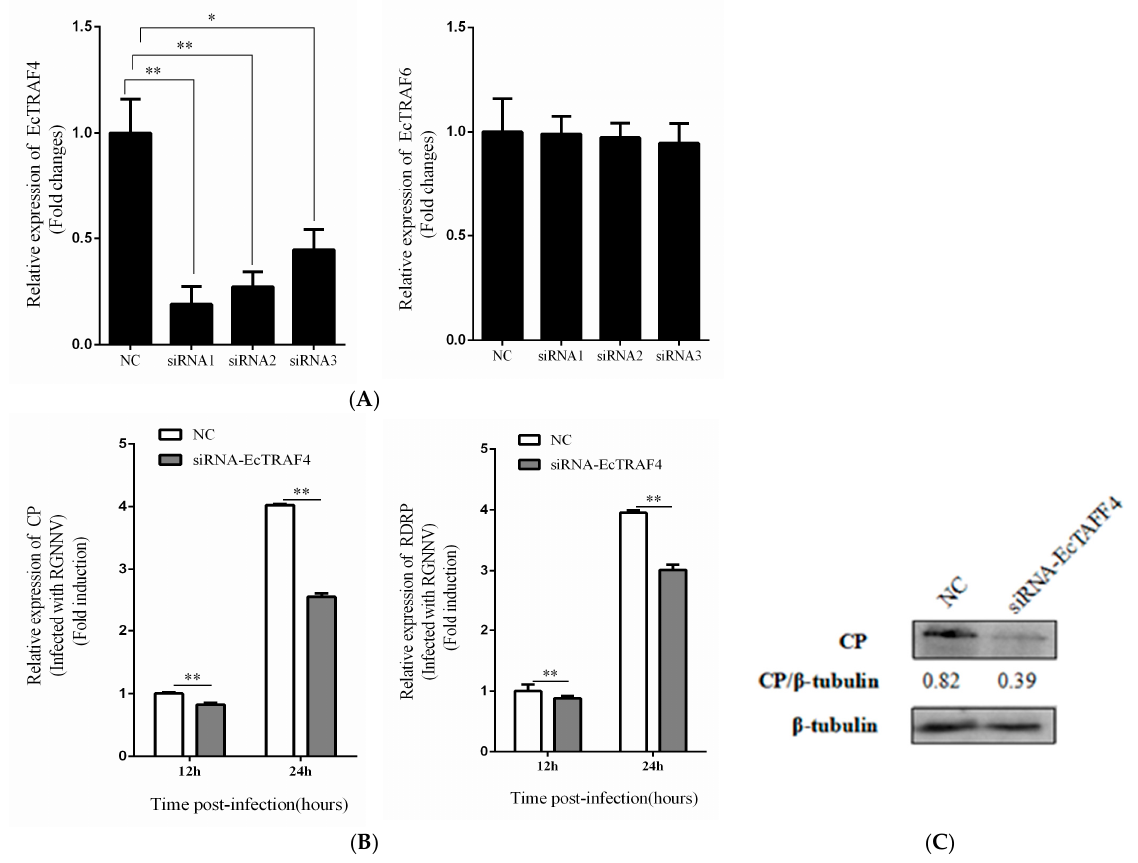
Figure 6. Effect of EcTRAF4 knockdown on RGNNV replication. ( A ) Three siRNA sequences were designed based on the sequence of EcTRAF4, the expression of EcTRAF4 was tested, and EcTRAF6 was used as the control (means ± S.E., n = 3). ( B ) Decreased RGNNV gene transcription, including CP and RdRp (means ± S.E., n = 3). Statistical difference is with each NC at a different time. Asterisk denotes a significant difference (* p < 0.05 and ** p < 0.01) ( C ) Virus protein level after transfection with siRNA1 of EcTRAF4. The level of RGNNV-CP was detected by western blot, and β -Tubulin was used as the internal control.